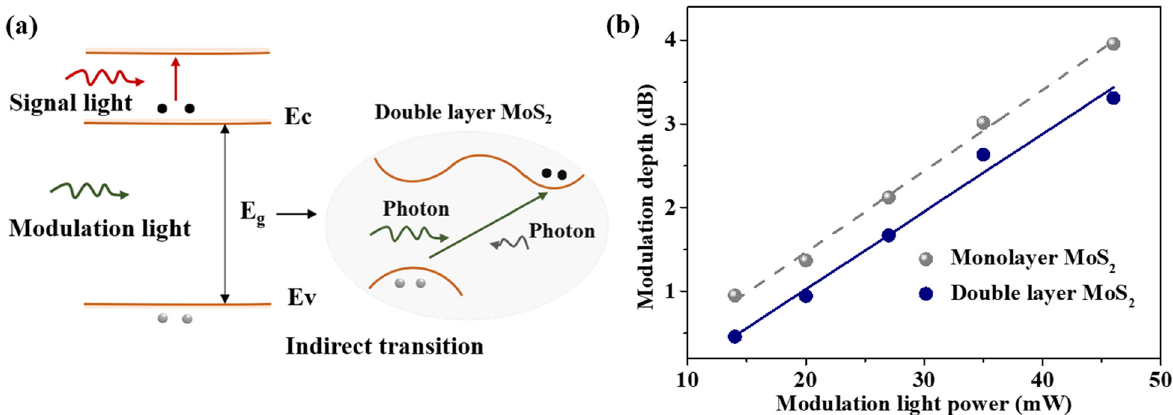
Figure 4: Double-layer MoS 2 -plasmonic nanoslit all-optical modulation. (a)Schematicofworkingprincipleforthedouble-layerMoS 2 device.(b)Modulationdepthofmonolayeranddouble-layerMoS 2 devicesversus modulation light